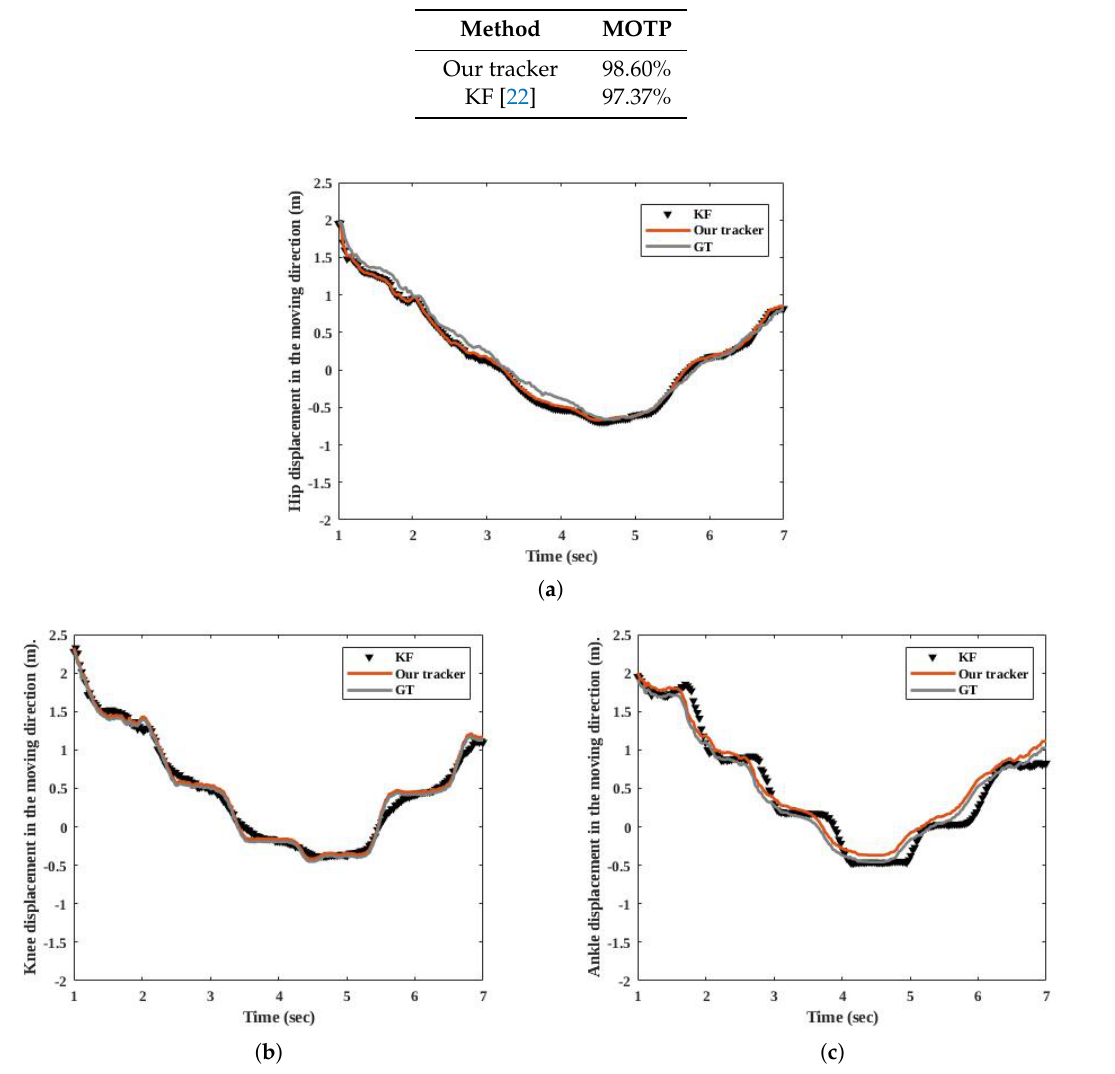
Figure 9. Measured and estimated results of the trackers for a person who was crossing in front of the camera. ( a ) shows the position of the hip joint in the left leg. ( b ) indicates the position of the knee joint in the left leg, and ( c ) compares the two trackers with each other based on the position of the ankle of the left